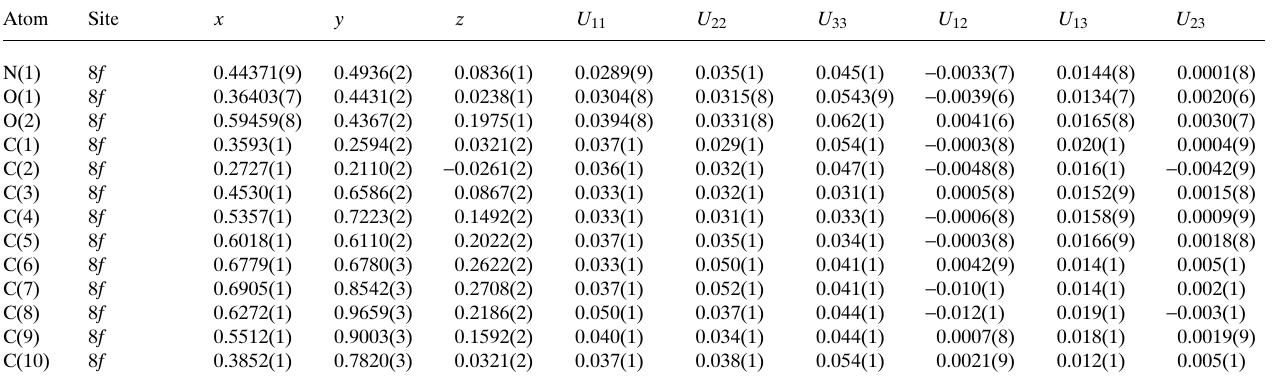
Table 3. Atomic coordinates and displacement parameters (in Å 2 ) .